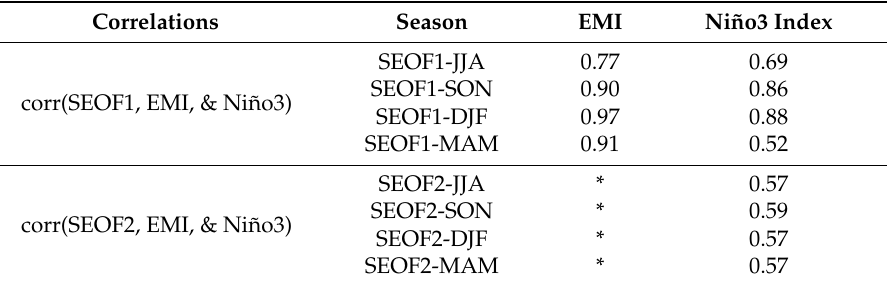
Table 2. Significant lagged correlation coefficients of the PCs of the SEOF modes and the El Niño Modoki Index (EMI) and Niño3